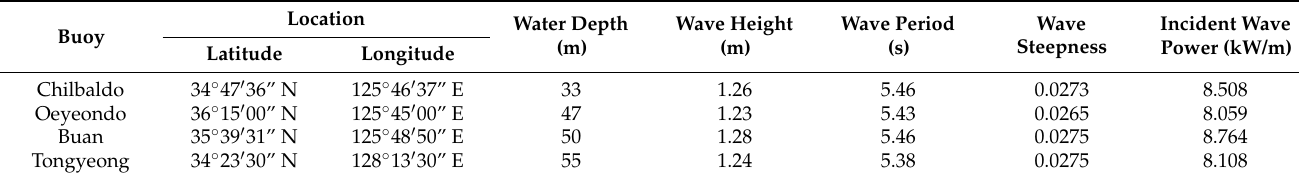
Table 2. Regular wave conditions calculated from buoy data in each selected area.